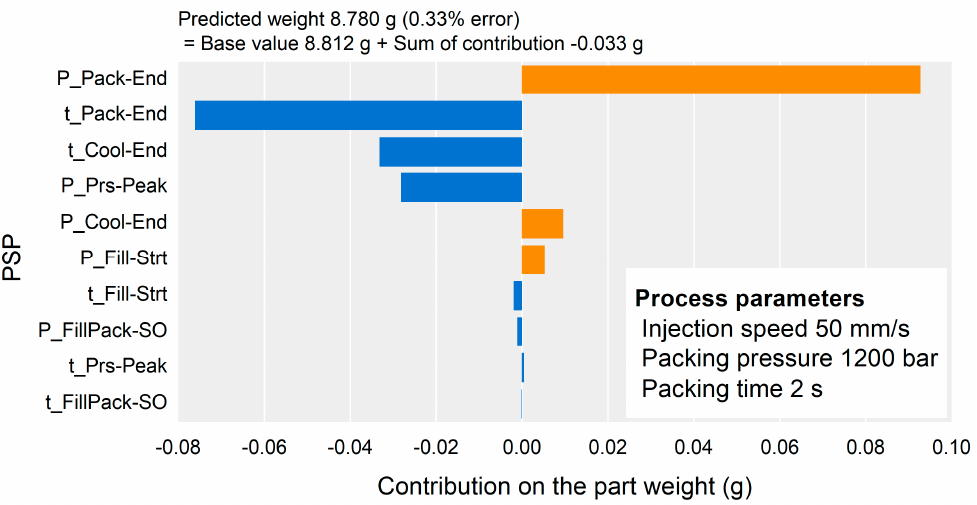
Figure 15. Contribution analysis result for the sample showing the contradictory effect of packing pressure and